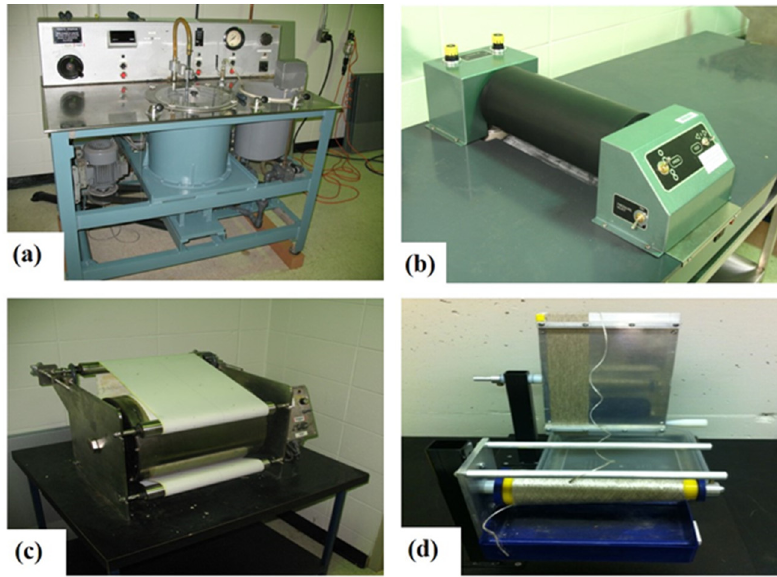
Figure 1. Equipment used for the reinforcement fabrication. ( a ) dynamic former; ( b ) press; ( c ) dryer and ( d ) alignment apparatus for the UD flax layer.